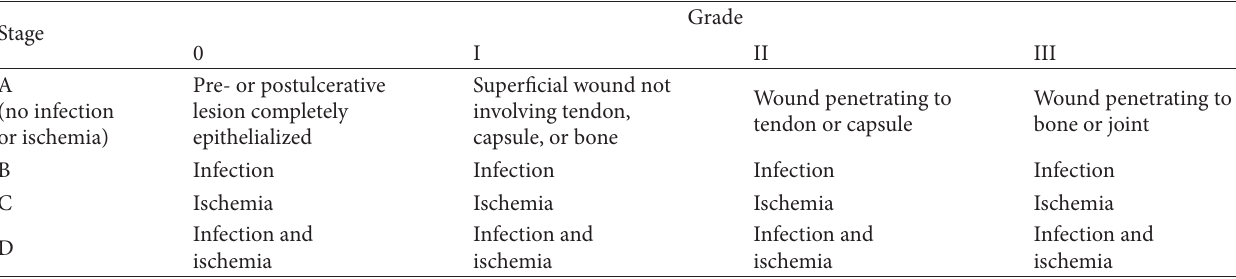
Table 2: Texas Wound